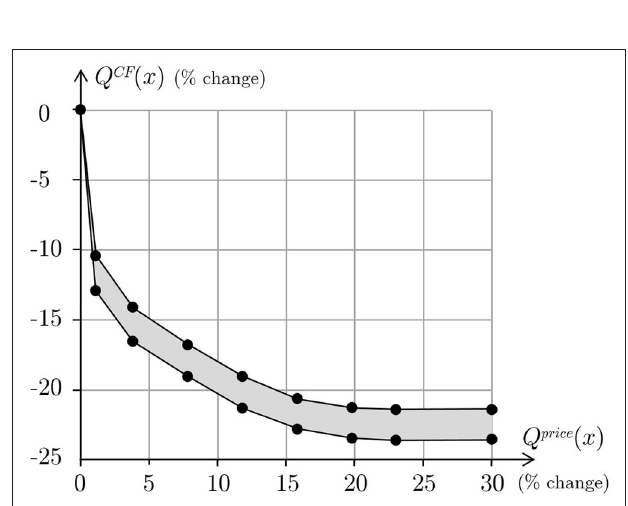
FIGURE 6 | Carbon footprint percentage change as a function of the percentage change of price, with respect to carbon footprint and price of the menus with minimum